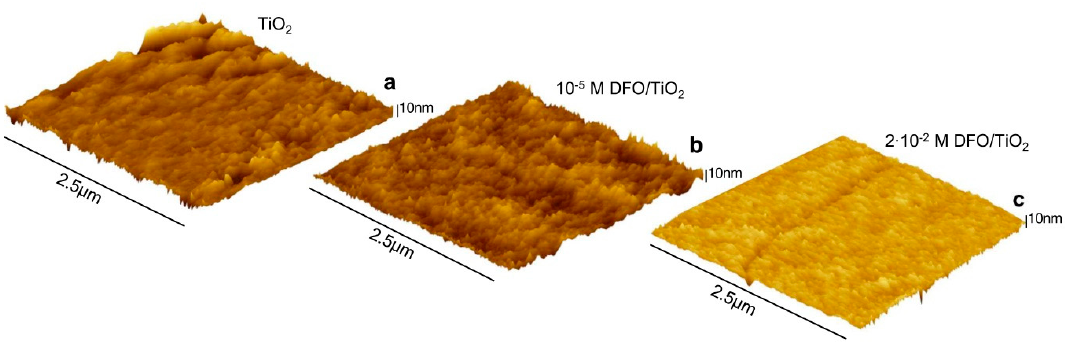
Figure 1. AFM image of thin films of: ( a ) TiO 2 ; ( b ) 10 − 5 M DFO/TiO 2 ; and ( c ) 2 ∙ 10 − 2 M DFO/TiO 2 .